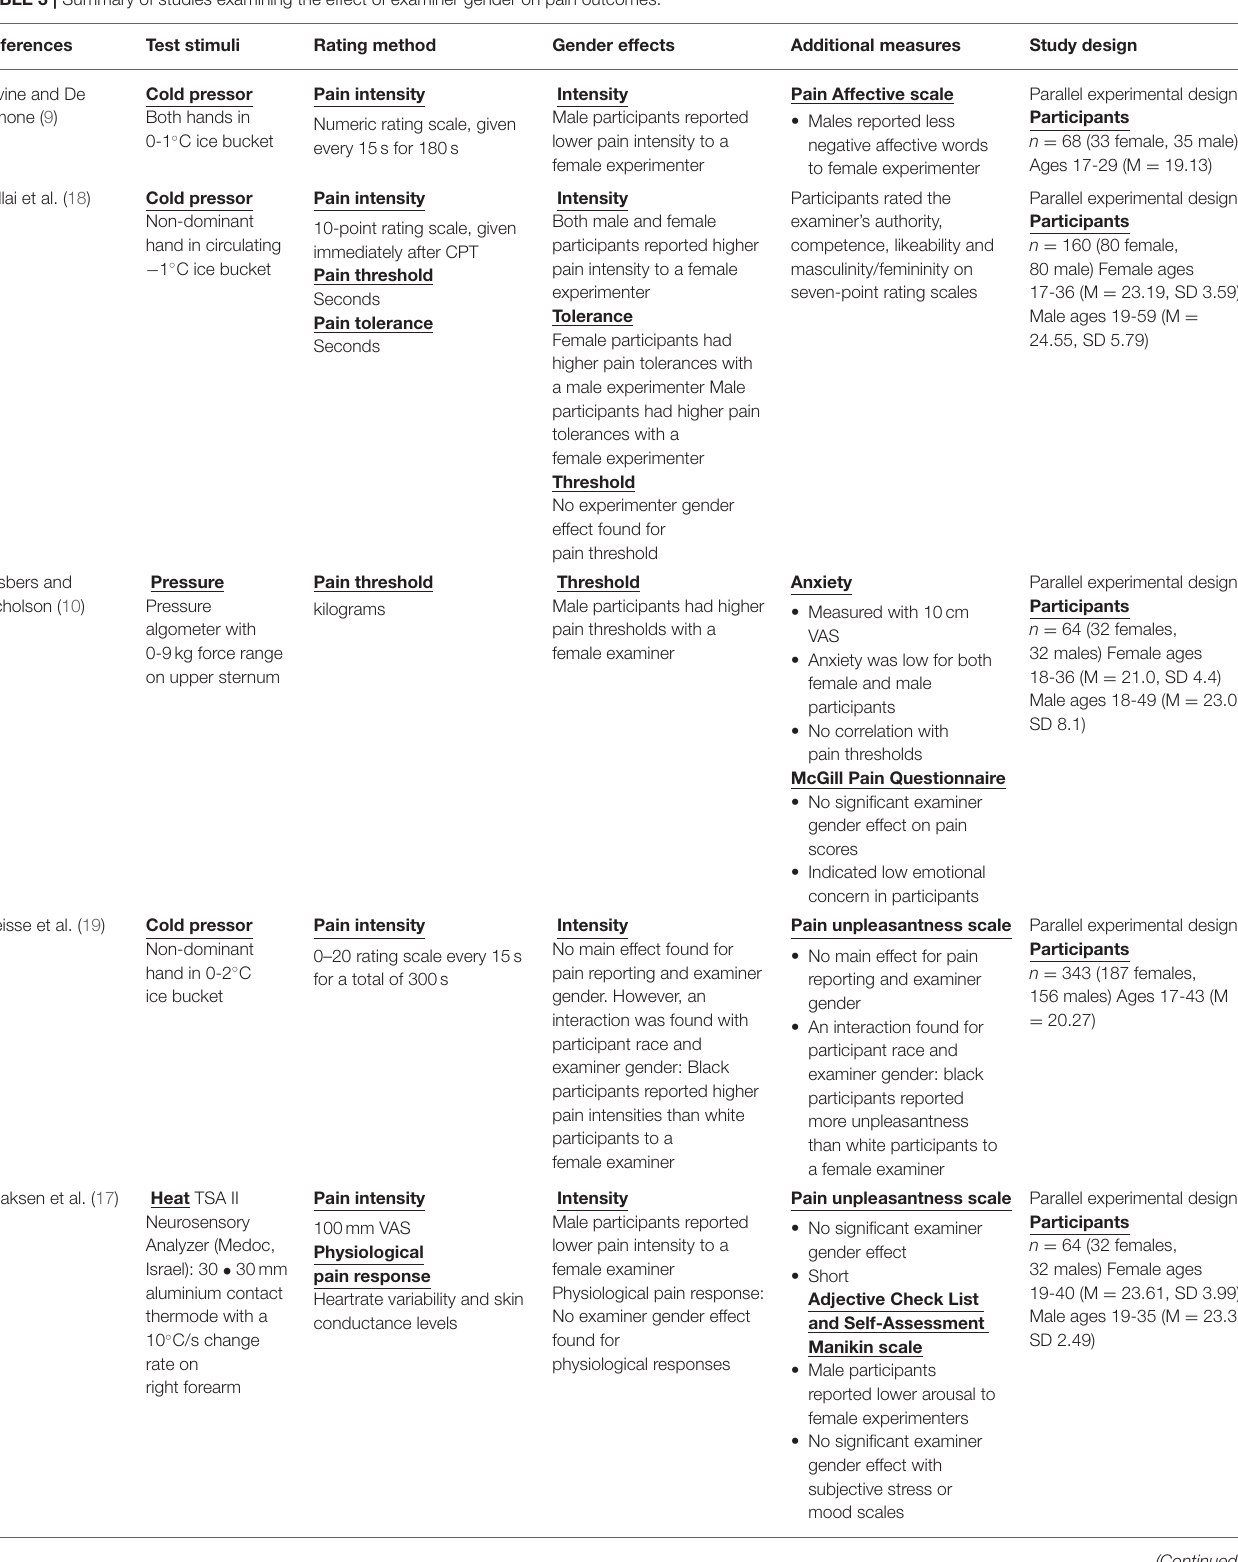
TABLE 3 | Summary of studies examining the effect of examiner gender on pain